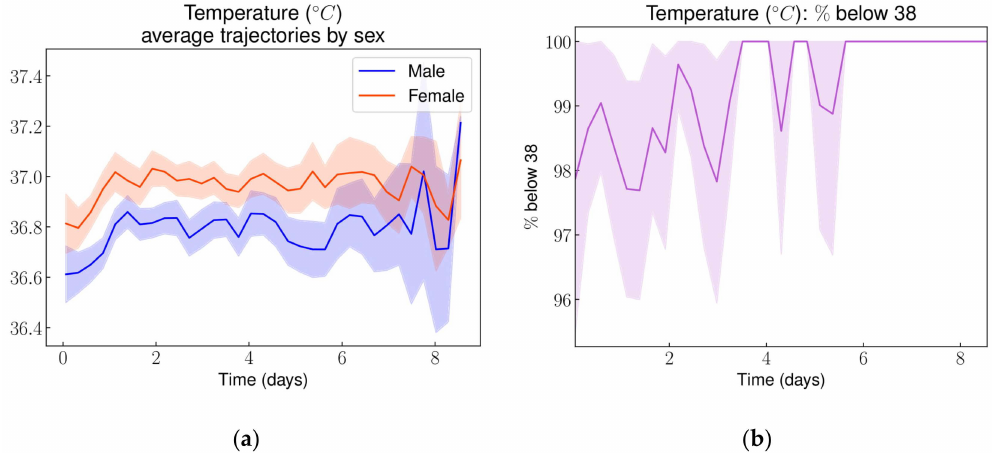
Figure A10. Temperature: ( a ) temperature average trajectory throughout non-complicated VOC-related hospital stays, stratified by sex; ( b ) percentage of patients with temperature < 38 ◦ C throughout non-complicated VOC-related hospital